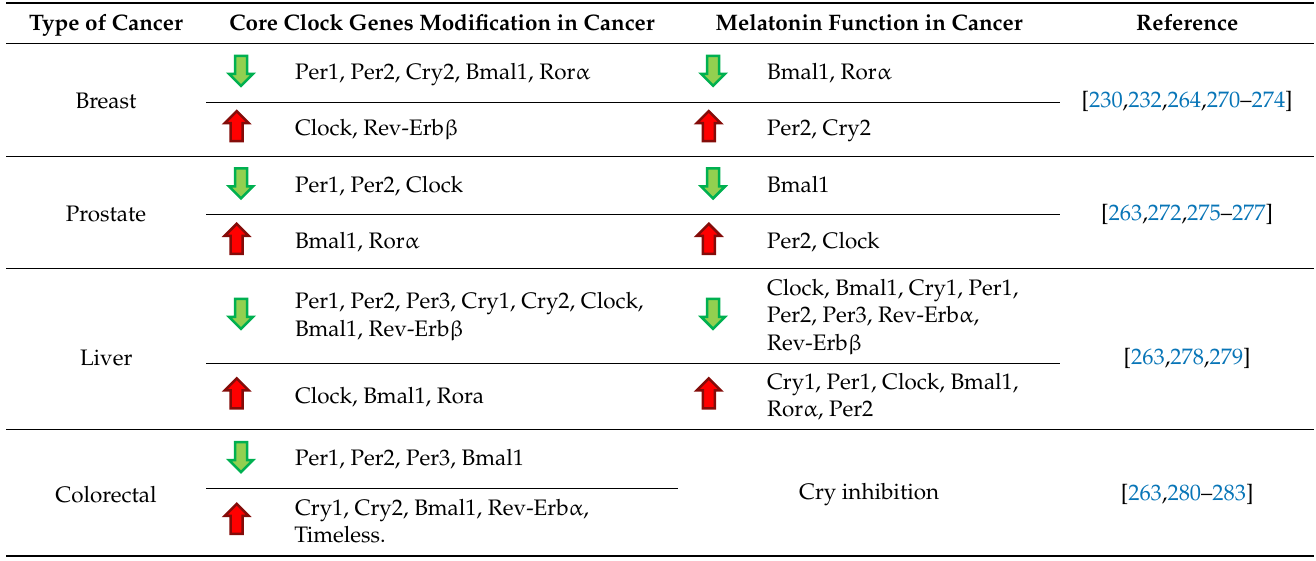
Table 2. Clock genes in different types of cancer.